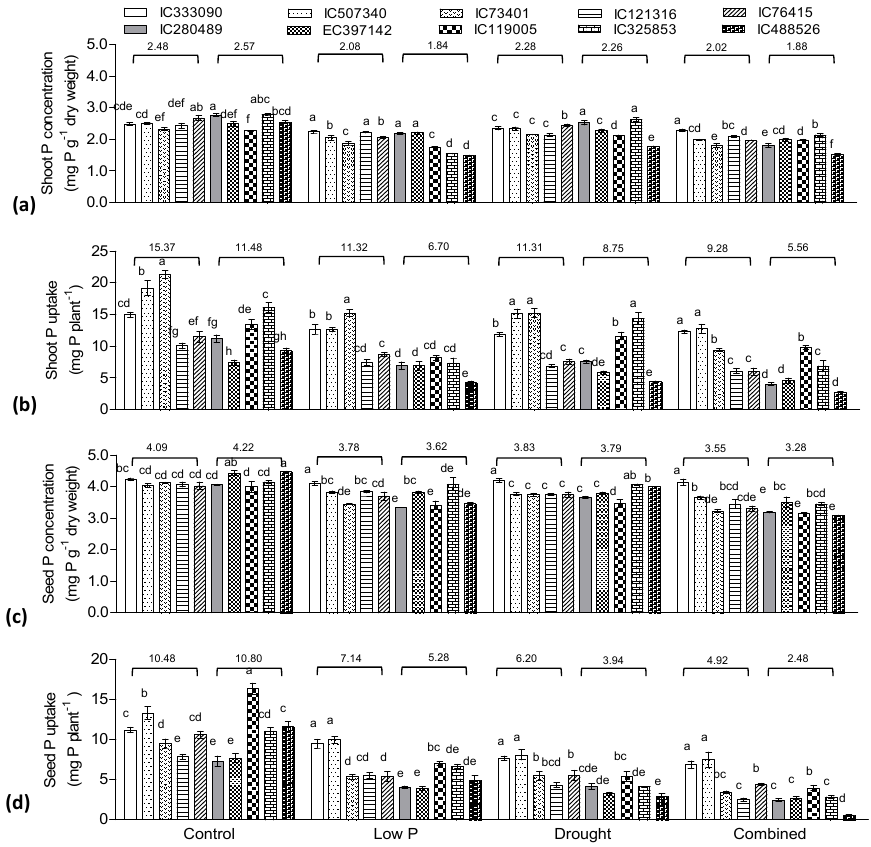
Figure 3. Effect of low P, drought, and combined stress on ( a ) shoot P concentration, ( b ) seed P concentration, ( c ) shoot P uptake, and ( d ) seed P uptake in 10 mung bean accessions. Values on bars 1–5 and 6–10 represents mean of tolerant and sensitive accessions, respectively. The letters on each bar denotes significant difference between accessions in each treatment. Error bars indicate mean ± SEm.